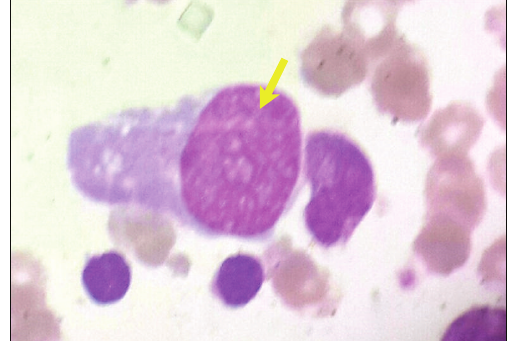
Figure 4: BM film Leishman stained and viewed at × 100 magnifica- tion. Shown is a representative field showing an abnormally large mononuclear cell with immature chromatin and pale basophilic cytoplasm (gold arrow) found throughout the aspirate. Based upon morphologic criteria, the abnormally large mononuclear cells appear